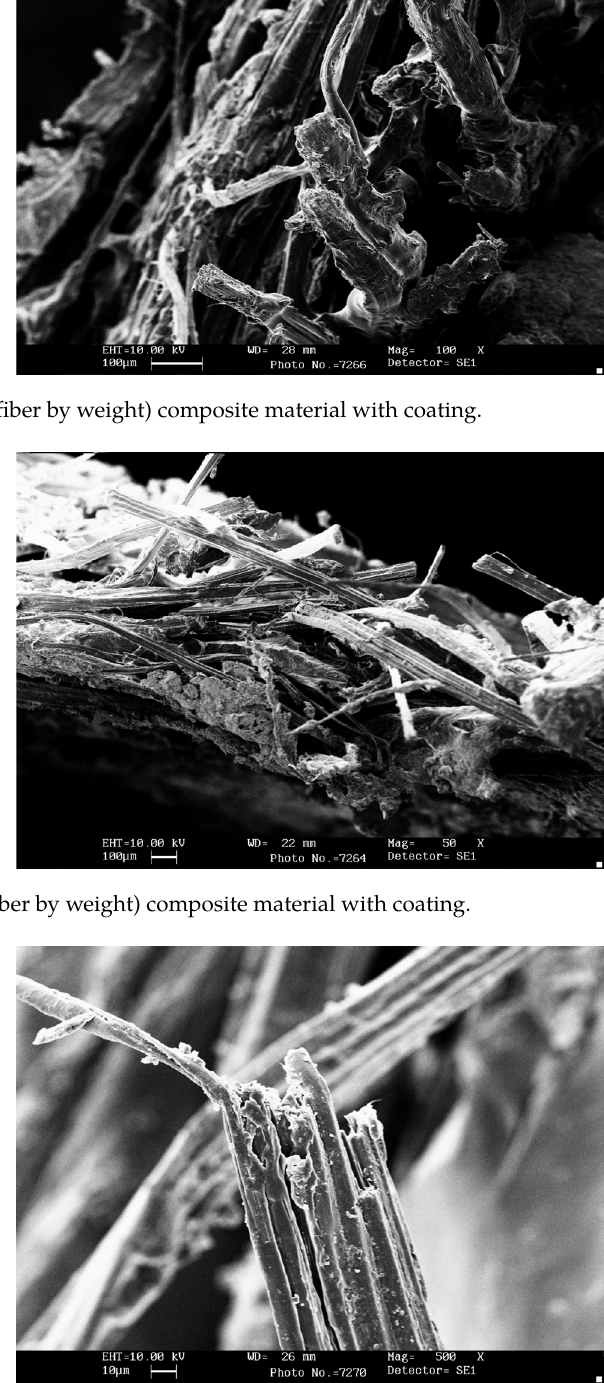
Figure 21: SEM for (15% jute fiber by weight) composite material without coating.